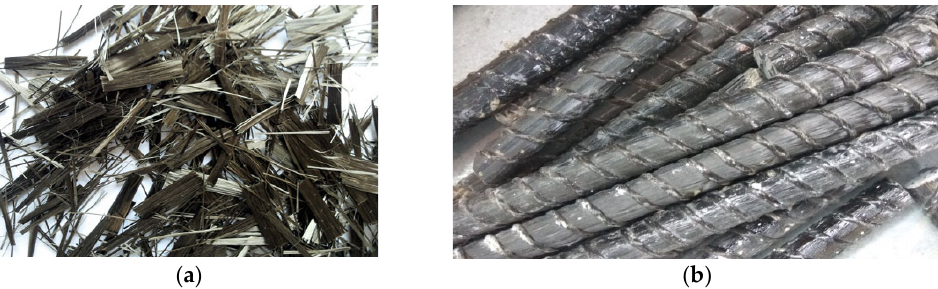
Figure 1. Reinforcement used in tests: ( a ) basalt fibers, ( b ) BFRP bars and stirrups.